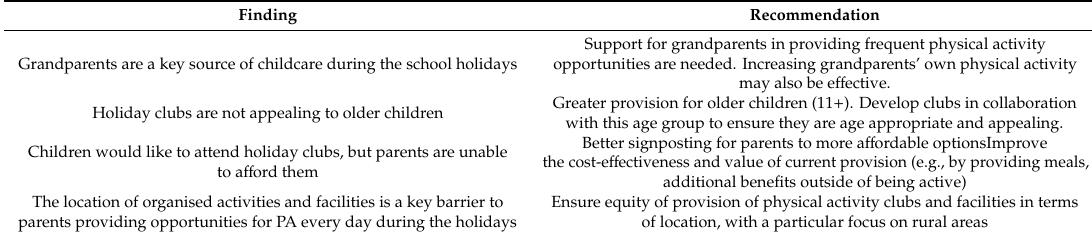
Table 2. Key findings and recommendations to support physical activity during